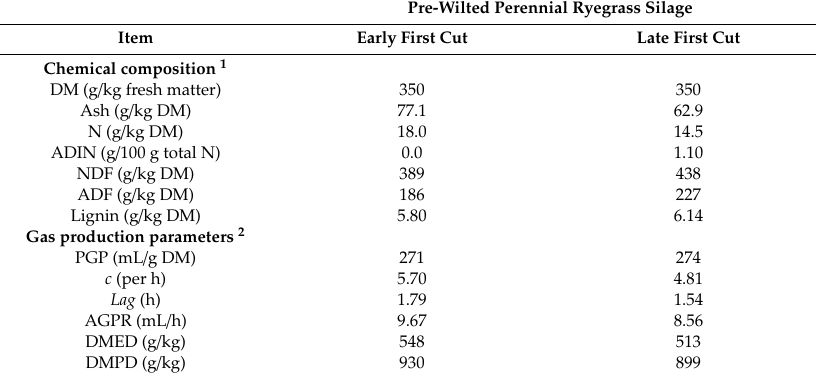
Table 6. Chemical composition of samples of early and late first cut of pre-wilted perennial ryegrass